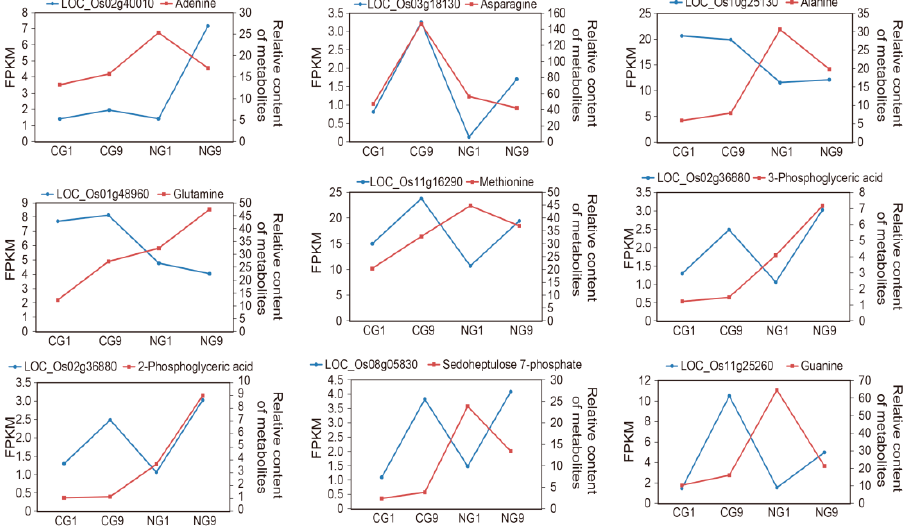
Figure 5. The coordinated changes of genes and the relative metabolites in G9 and G1 under con ‐ trol and LN